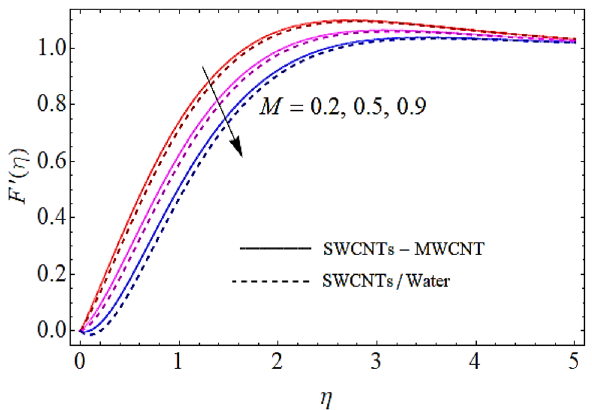
Figure 2. Flow characteristics versus M when (cid:31) = 0.2, ϕ 1 = 0.02, ϕ 2 = 0.01, K = 0.7